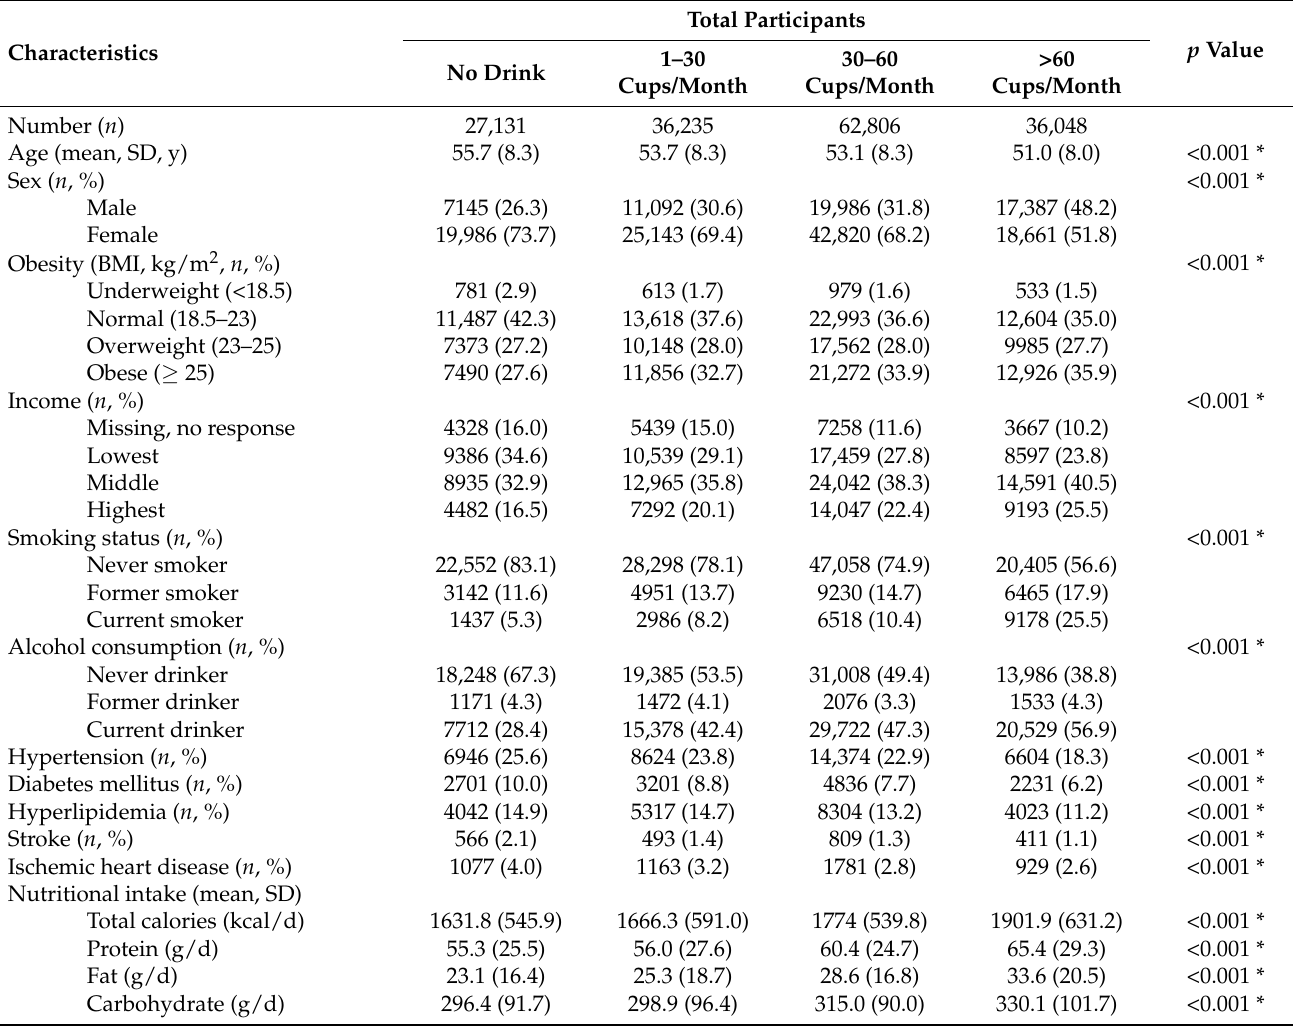
Table 1. General Characteristics of